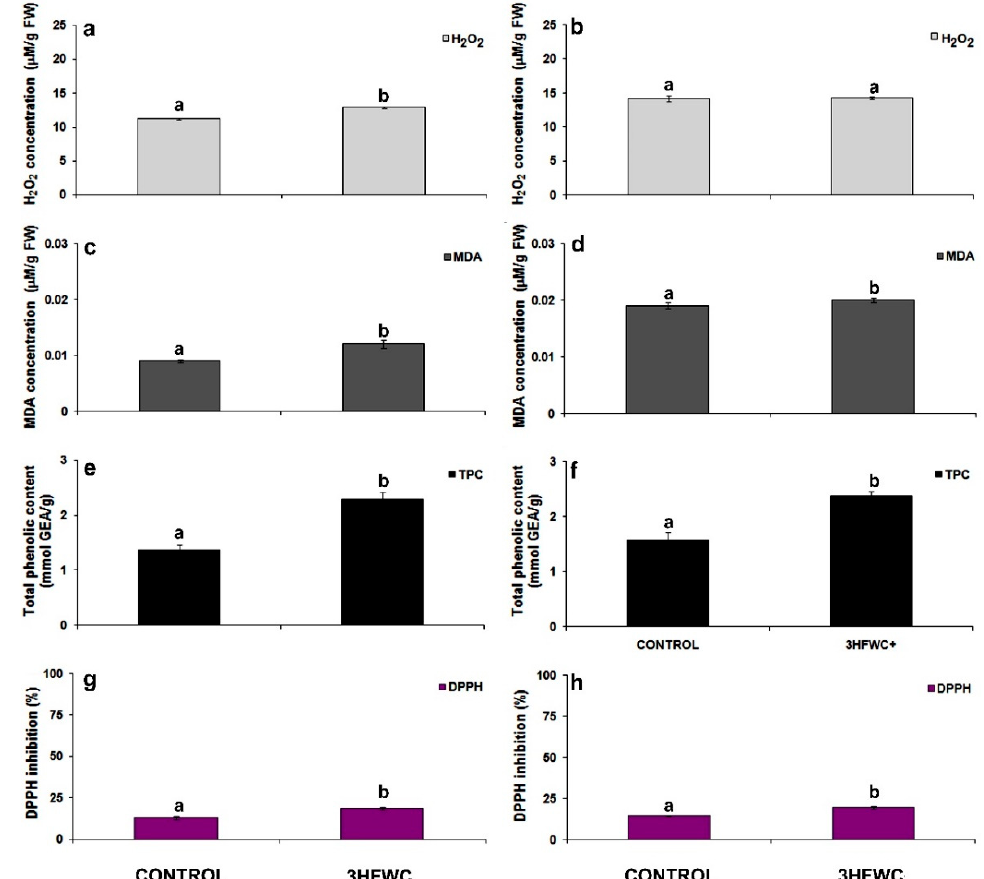
Figure 4. The effect of 3HFWC substance on hydrogen peroxide (H 2 O 2 ), malondialdehyde (MDA), total phenolic content (TPC) and DPPH activity in cherry tomato leaves: ( a , b ) H 2 O 2 content in cherry tomato leaves after four ( a ) and 12 weeks ( b ) of growth; ( c , d ) MDA content in cherry tomato leaves after four ( c ) and 12 weeks ( d ) of growth; ( e , f ) TTC content in cherry tomato leaves after four ( e ) and 12 weeks ( f ) of growth; ( g , h ) DPPH activity cherry tomato leaves after four ( g ) and 12 weeks ( h ) of growth. The presented data are mean value ± standard error. Different letters indicate statistically significant differences according to LSD test ( p ≤ 0.05).